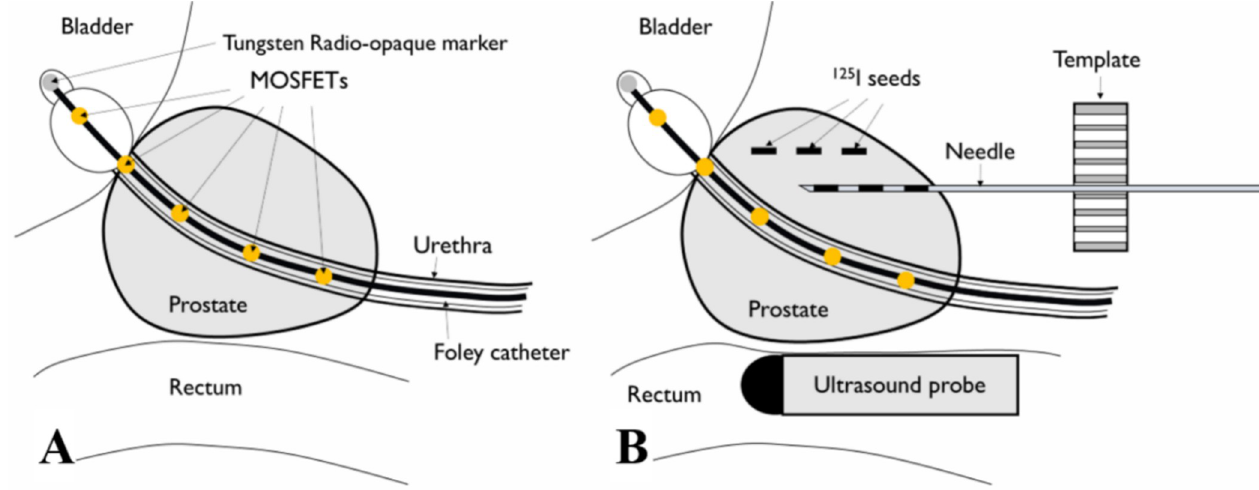
Fig 2. Schematic illustration of the relative location of transrectal ultrasound (TRUS), metal-oxide–semiconductor field-effect transistor (MOSFET), and implanted seeds during the low-dose-rate prostate brachytherapy procedure. (A) MOSFET is inserted through a Foley catheter, and the second probe is usually located at the bladder neck. (B) The needle containing radioactive seeds goes through the template under real-time guidance based on TRUS images. After the needles are removed, the radioactive seeds remain implanted in the prostate.